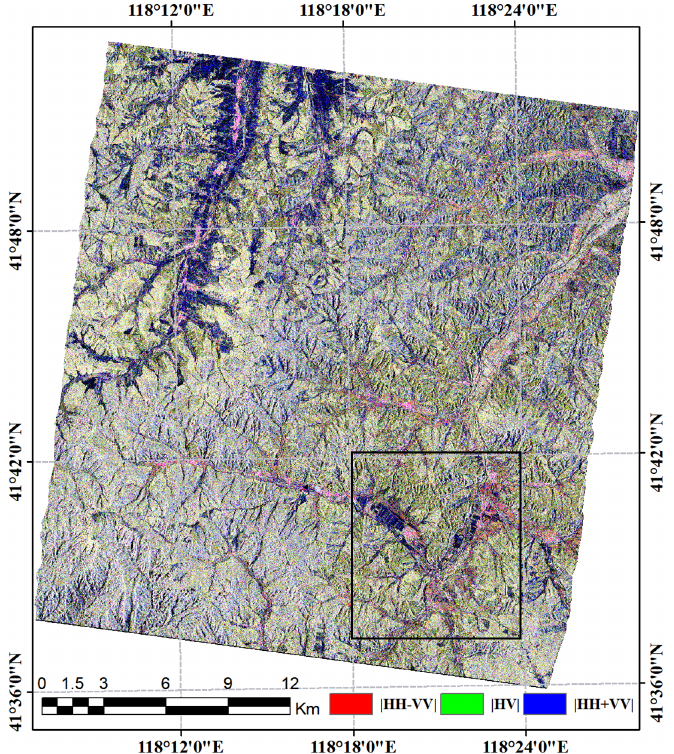
Figure 10. The Pauli RGB after RTC based on RD model using GAMMA software (version: 2012).